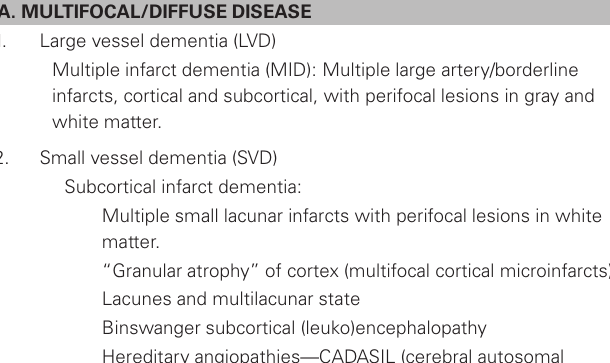
Table 7 | Classification of VaD according to major morphologic